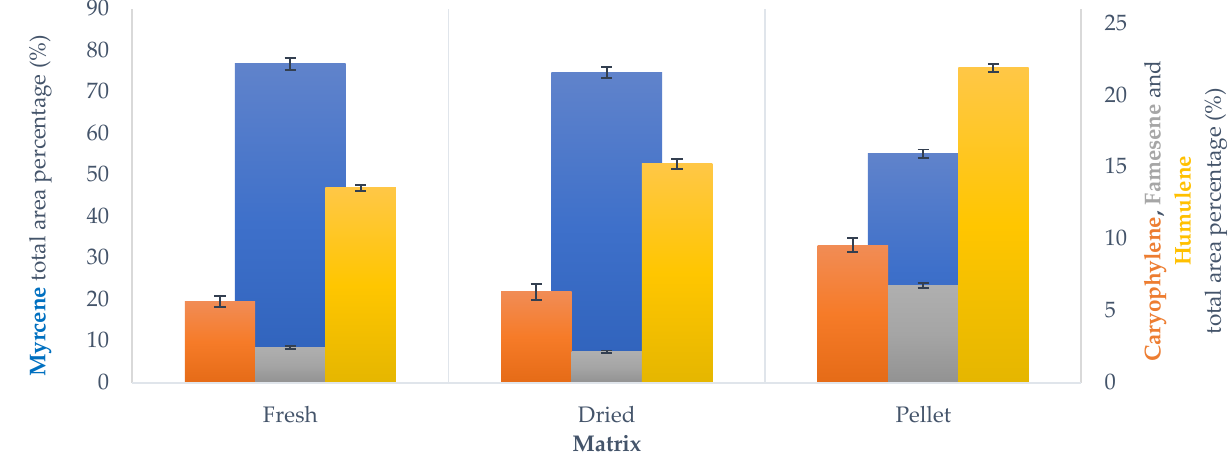
Figure 8. Main terpenoid distribution across SOP MAHD screenings, GC-MS analysis. Results reported as average ± SD.